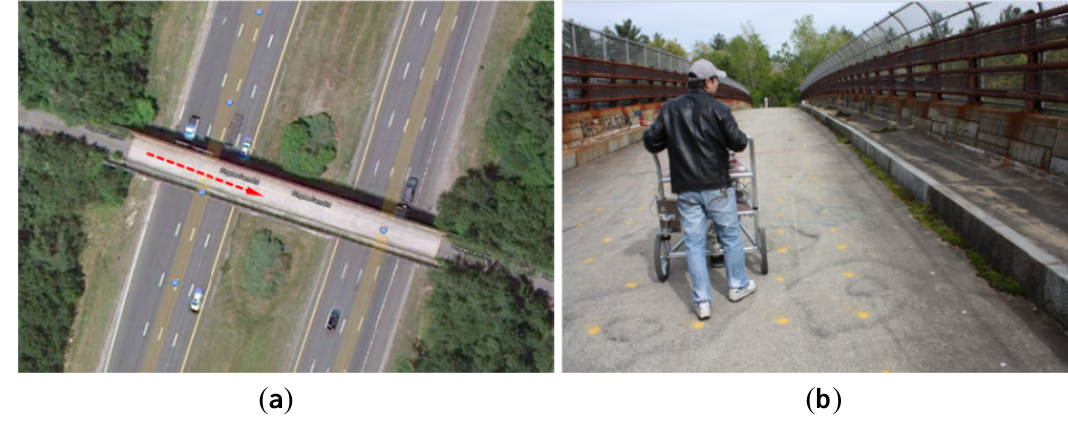
Figure 13. Pingree bridge deck test (Rowley, MA, USA). ( a ) Scanning path on bridge deck. ( b ) MASS operation on bridge deck.